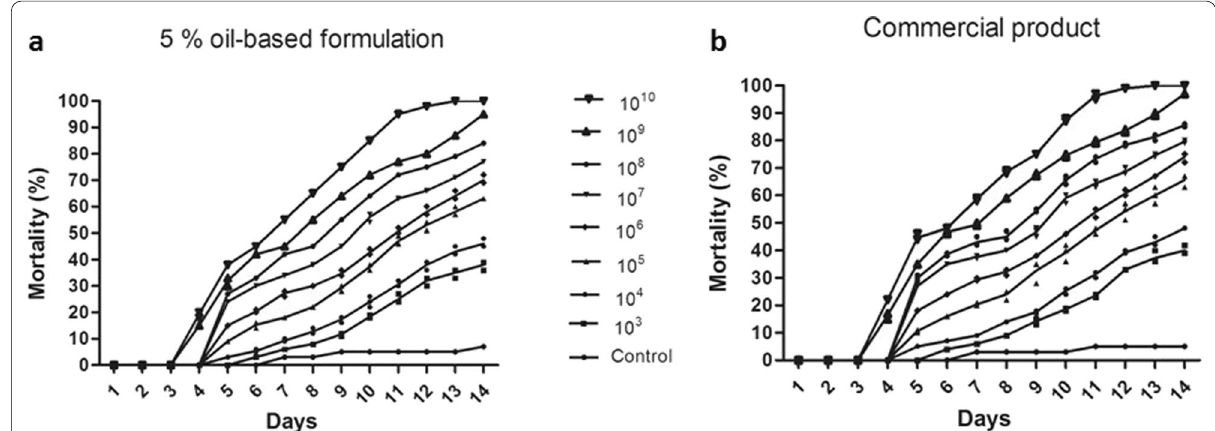
Fig. 2 Concentration response values of control group, 5% oil formulation and commercial product on 3rd instar Helicoverpa armigera larvae